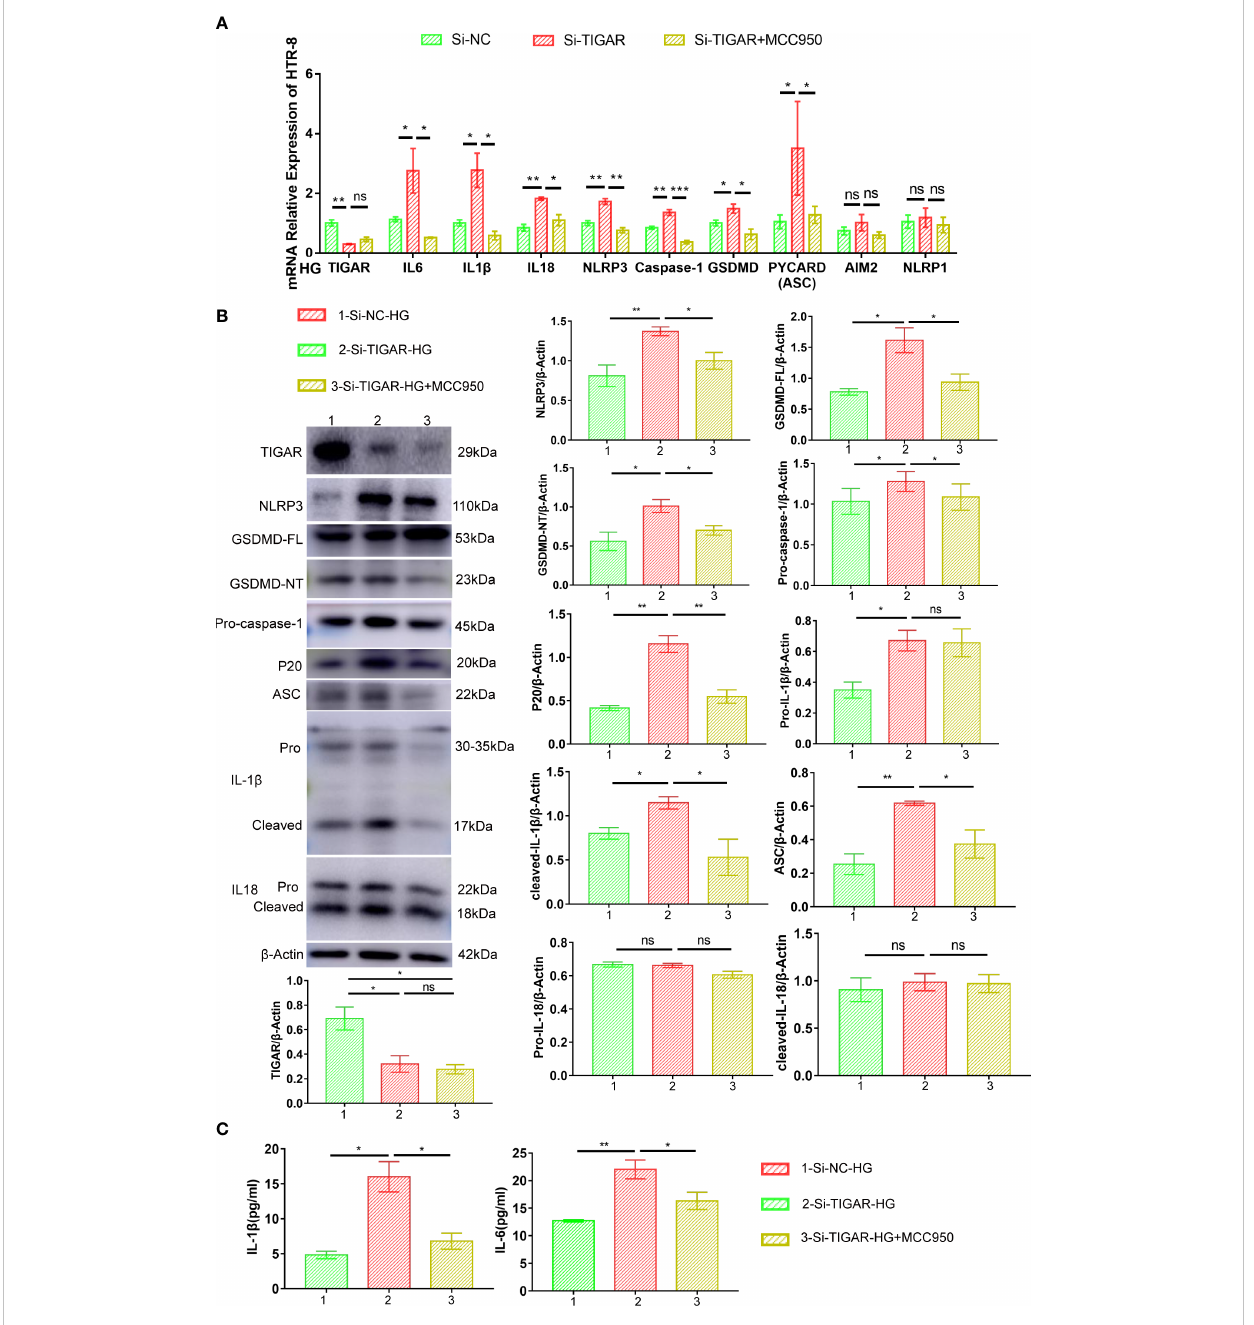
FIGURE 5 MCC950 treatment hindered the development of in fl ammation and pyroptosis. Real-time PCR (A) and western blotting (B) was used to analyze the expression of proin fl ammatory cytokines (Pro-IL-1 b , cleaved-IL-1 b , IL18 and IL-6) and pyroptosis factors (NLRP3, ASC, GSDMD-FL, GSDMD-NT, Pro- caspase-1, P20). The expression of these proteins was quanti fi ed by normalizing to b -actin ( n=3 ) (right). (C) IL-1 b and IL-6 in the supernatant were measured by ELISA. Data of the triple experiments are presented as the means ± SEM. *p < 0.05, **p < 0.01, ***p < 0.001 versus the indicated group, ns, no signi fi